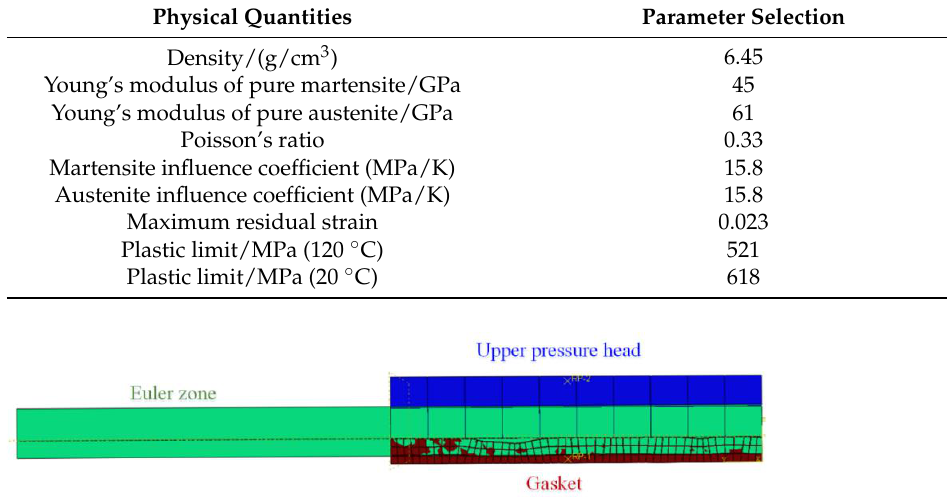
Figure 5. Geometric model of Euler-Lagrange coupling analysis method.